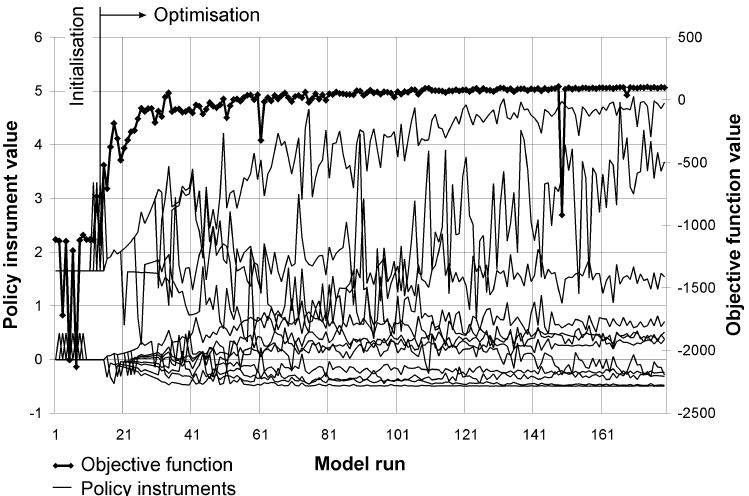
Figure 7: Convergence of the optimisation process